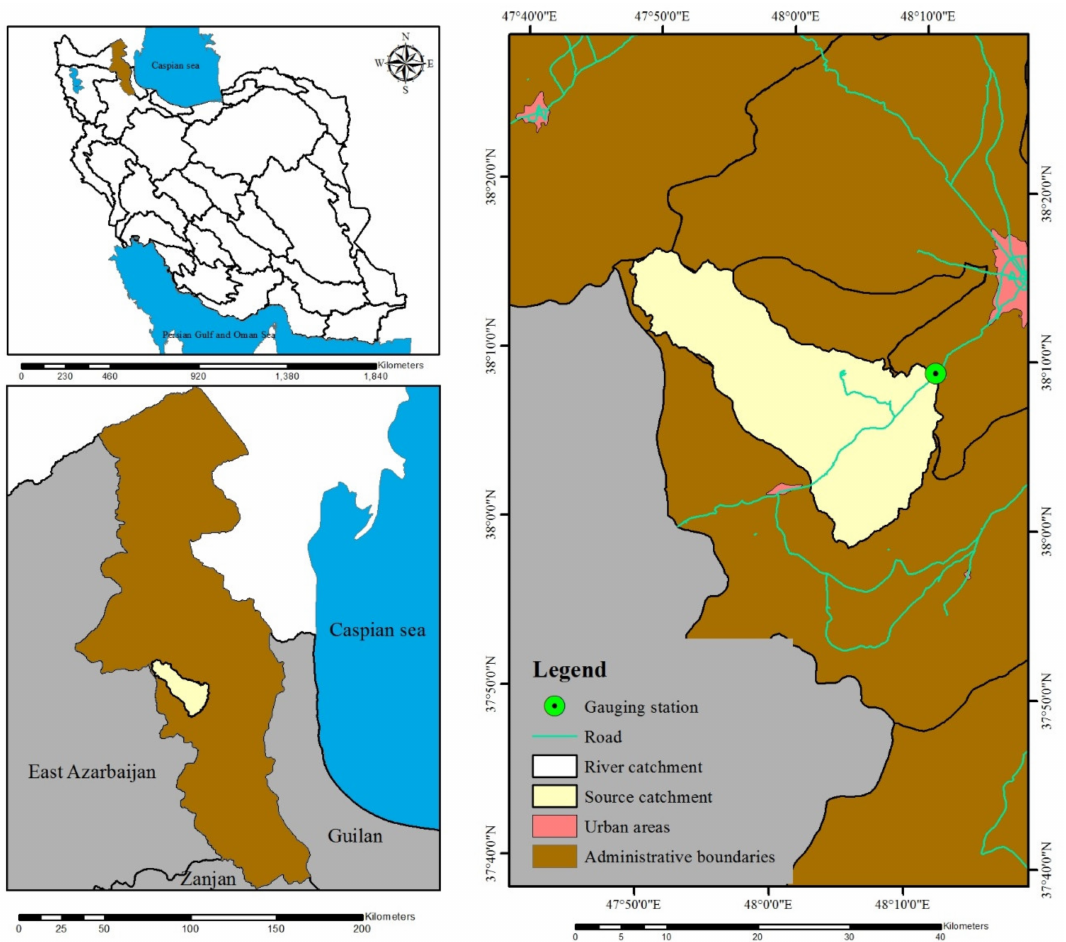
Figure 1. Geographical location of the source